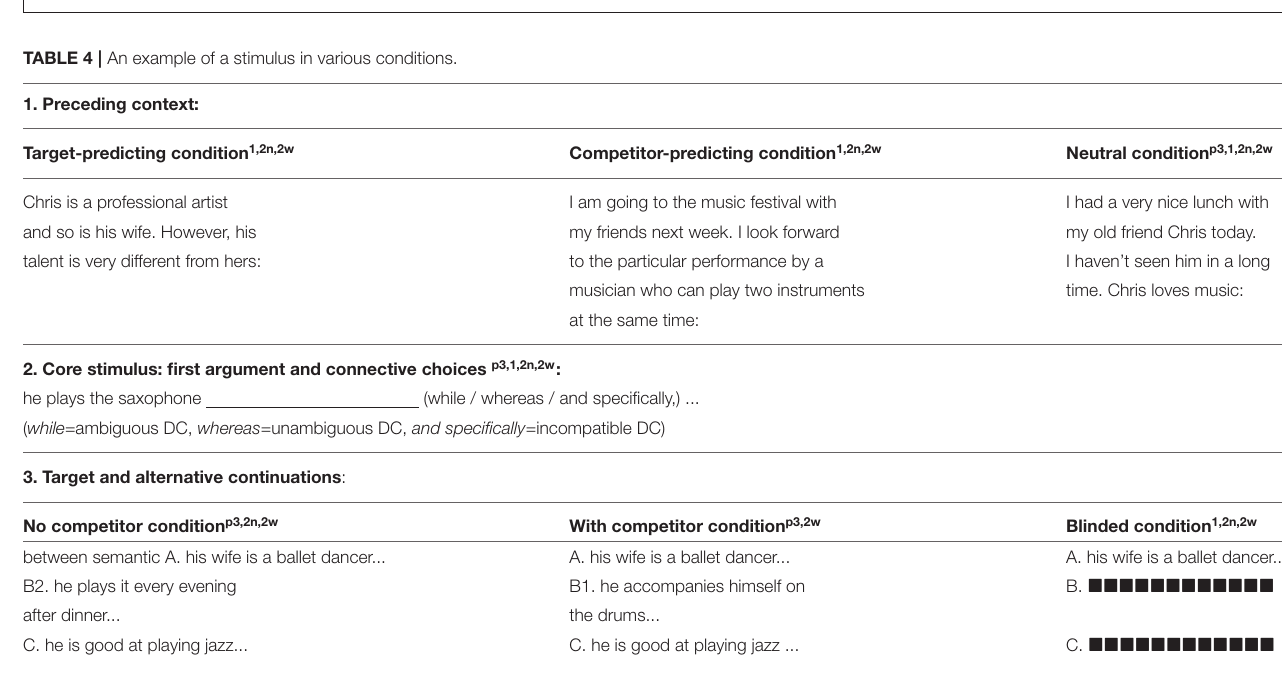
FIGURE 2 | Distribution of proportion of the DC choices made each participant in Experiment 1.